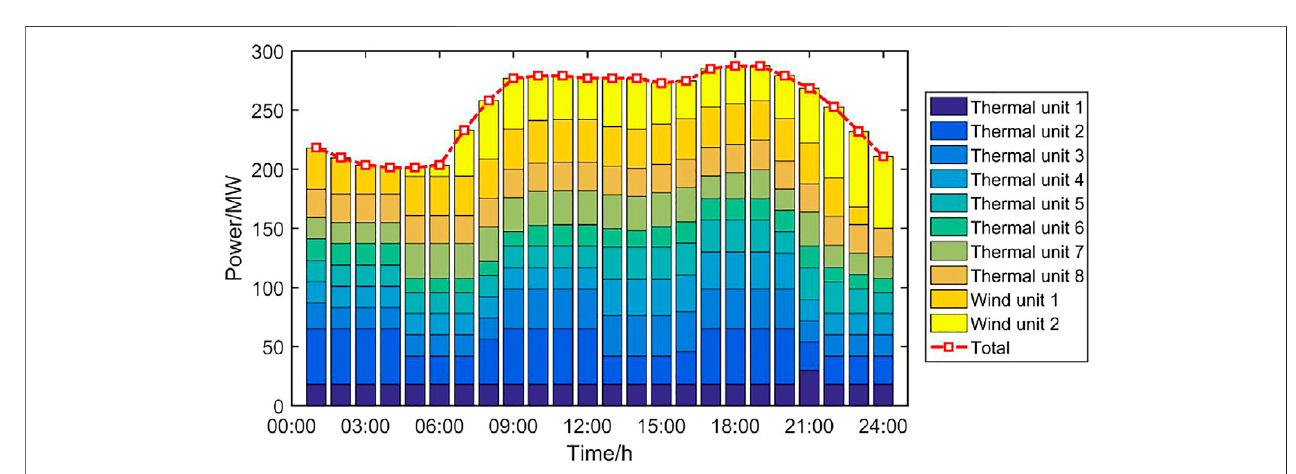
FIGURE 8 | Clearing energy of the market considering 25% wind power